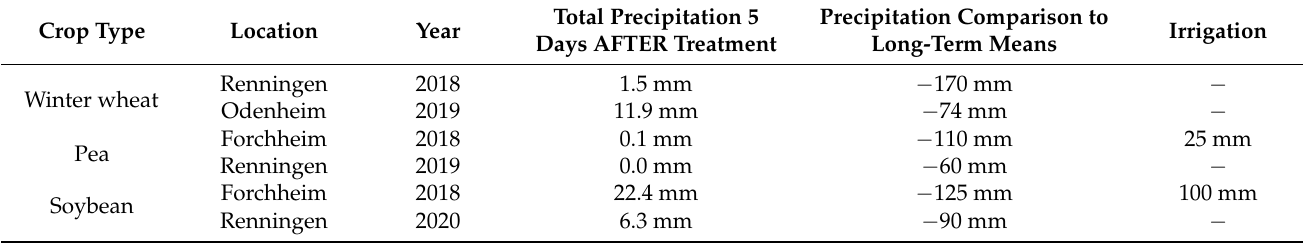
Table 4. Amount of irrigation and precipitation and difference of precipitation to the long-term average means between sowing date and